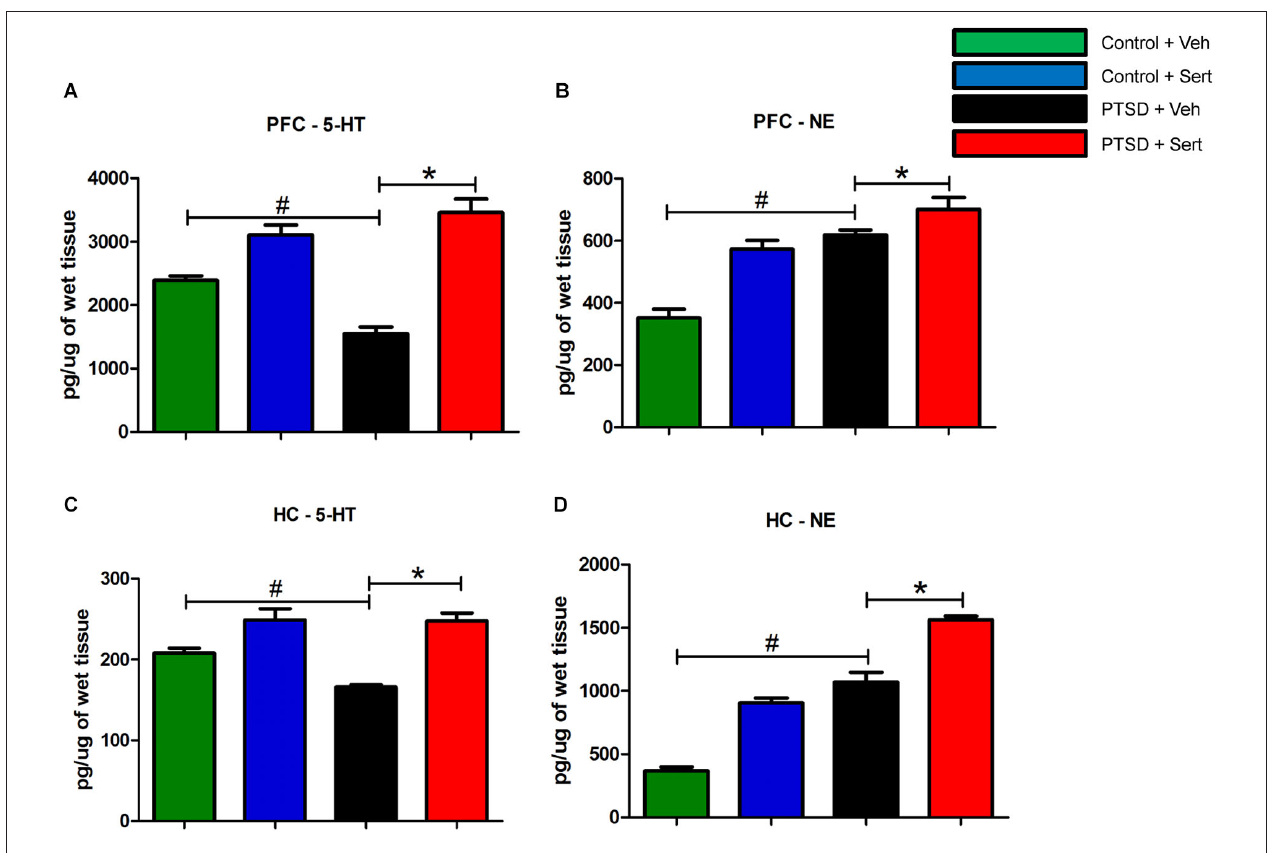
5-HT (C) was significantly lower in the PTSD + Veh vs. the control + Veh group, while NE (D) was higher. Similar to results in the PFC, sertraline normalized 5-HT to pre-stress levels, but it doubled NE in the control + Sert group and more than tripled NE in the PTSD + Sert group compared to the control + Veh group (D) . All data are presented as mean ± SEM. * p < 0.05 between the PTSD groups. # p < 0.05 between the vehicle